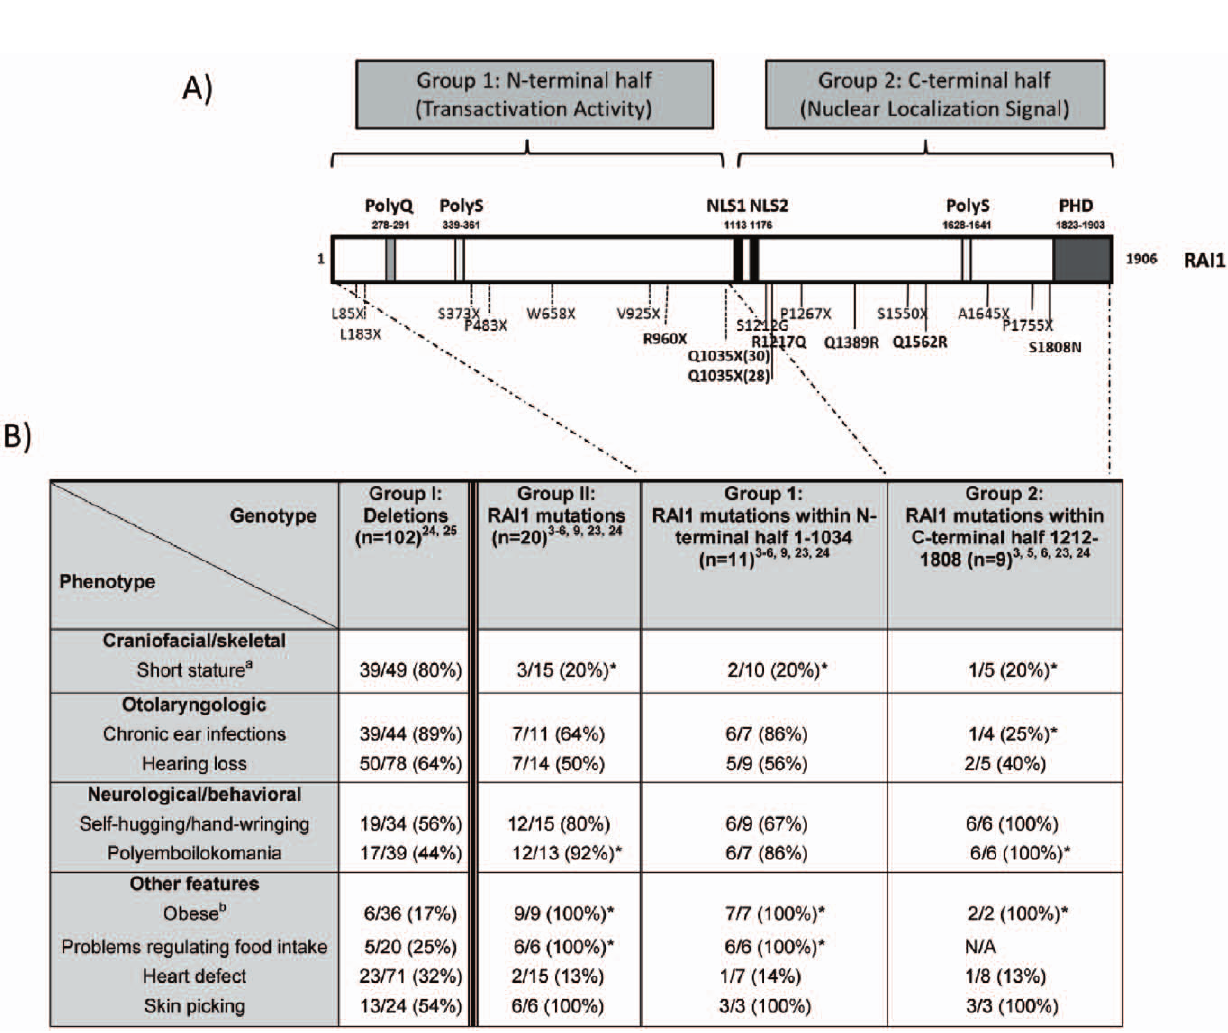
Figure 1. Schematic representation RAI1 protein structure and point mutations associated with the SMS phenotype. A) The structure of isoform 1 of RAI1 protein is schematically represented and the following domains are indicated according to their amino acidic position: polyglutamine tract (PolyQ), two different polyserine tracts (PolyS), a plant homeo domain PHD and bipartite nuclear localization signals, NLSs. Twenty SMS patients harboring a RAI1 point mutation are depicted: two nonsense, five missense and eleven frameshift mutations (including four patients with Q1035X). The two groups of mutations are represented. The mutations analyzed in the present study are shown in bold. B) Clinical features previously described as significantly different between SMS patients harboring a common, large, small or atypical deletion or RAI1 point mutation [25] are listed. Four sets of comparisons are shown: 1. between SMS patients harboring a deletion versus RAI1 point mutation (groups I and II), 2. between SMS patients harboring a deletion versus RAI1 point mutation in the N-terminal half of the protein (groups I and 1), 3. between SMS patients harboring a deletion versus RAI1 point mutation in the C-terminal half (groups I and 2), 4. between SMS patients harboring a RAI1 point mutation in the N-terminal half versus the C-terminal half (groups 1 and 2). The significant differences found in each set of comparisons are represented with an asterisk (*=p , 0.05). a: short stature ( , 5 th percentile); b: Obese classification based on Body Mass Index (BMI): BMI . 95 th percentile for children and adolescents; BMI . 30 for adults. N/A=not